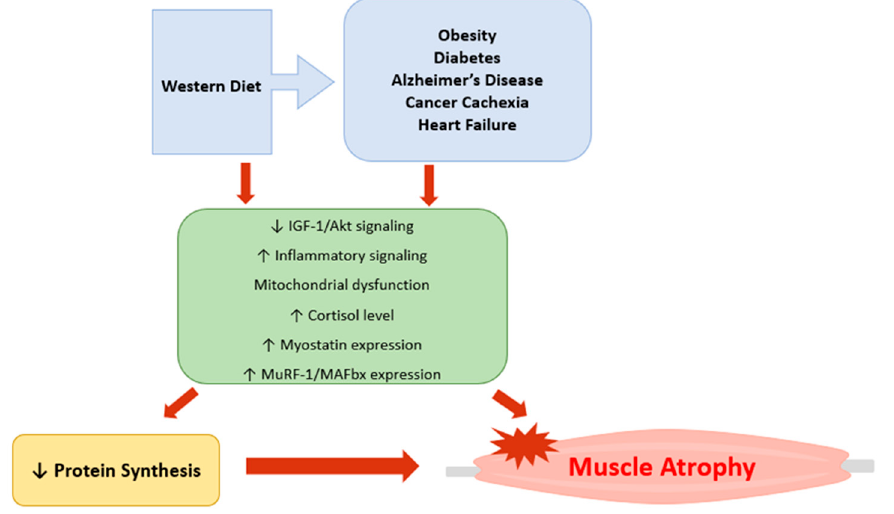
Figure 1. Graphic representation of the major mechanisms involved in skeletal muscle atrophy. Western diet pattern, obesity, diabetes, Alzheimer’s disease, cancer cachexia, and heart failure reduce protein synthesis by inhibiting IGF-1/Akt signaling and increasing inflammatory signaling, myostatin expression, and atrogenes (MuRF-1 and MAFbx). Mitochondrial dysfunction has also been implicated in development of muscle atrophy. Imbalance between the rate of protein synthesis and degradation can also lead to muscle